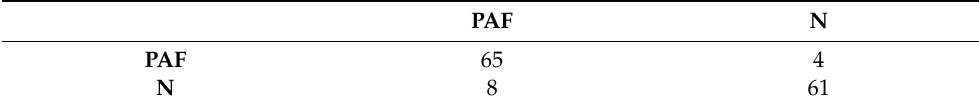
Table 7. Classification results of the prediction models in the FZU-FPH test set.